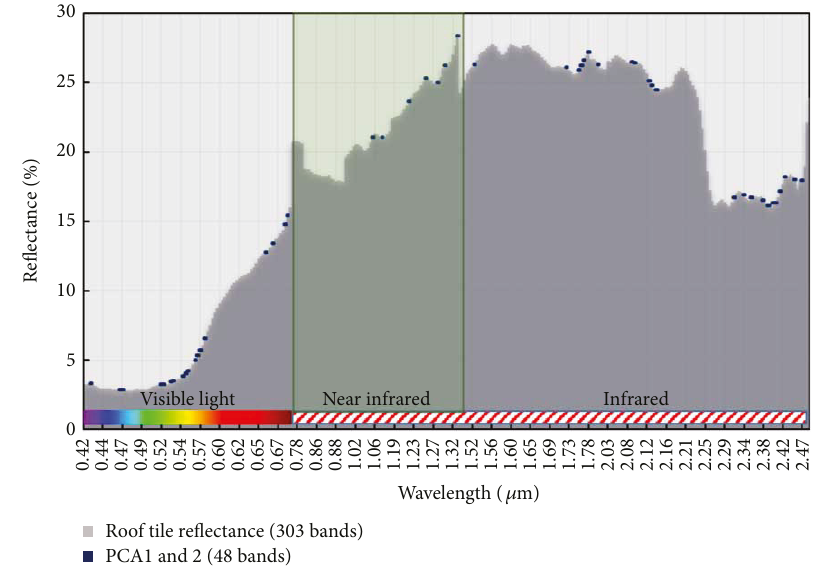
Figure 2: BS-PCA1 and 2 band positions over spectral curve of ceramic tile